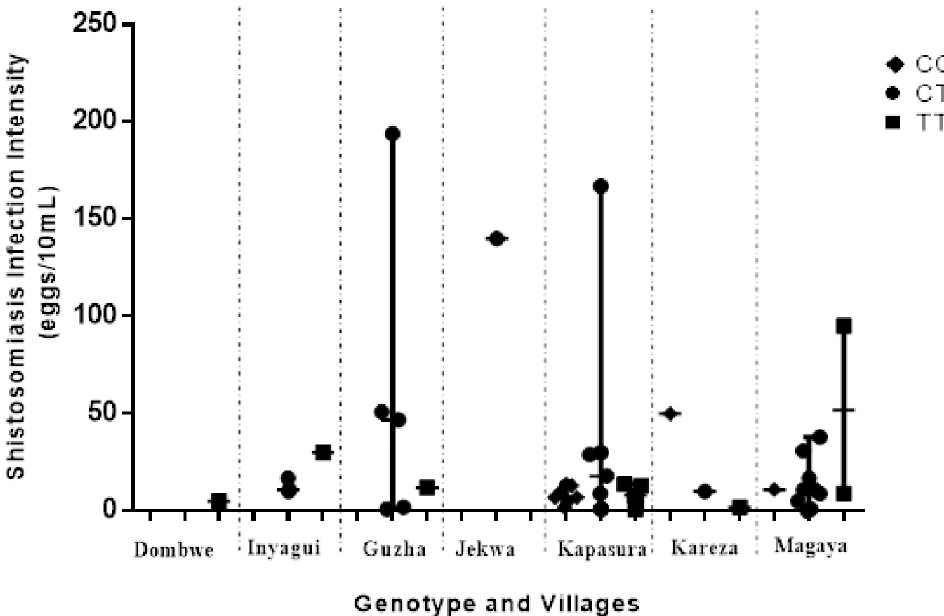
Fig 1. Comparison of IL-13-1112C/T genotype of S . haematobium among individuals in different villages.